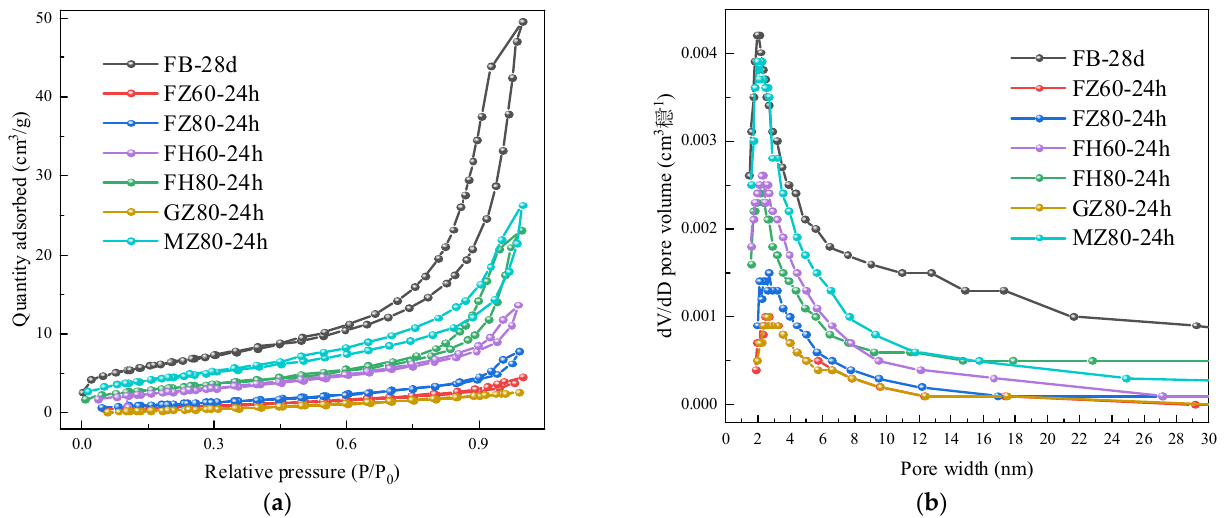
Figure 8. BET test results of alkali-activated cement under different curing conditions: ( a ) AAF after 7 d/8 h curing; ( b ) AAF after 28 d/24 h curing.